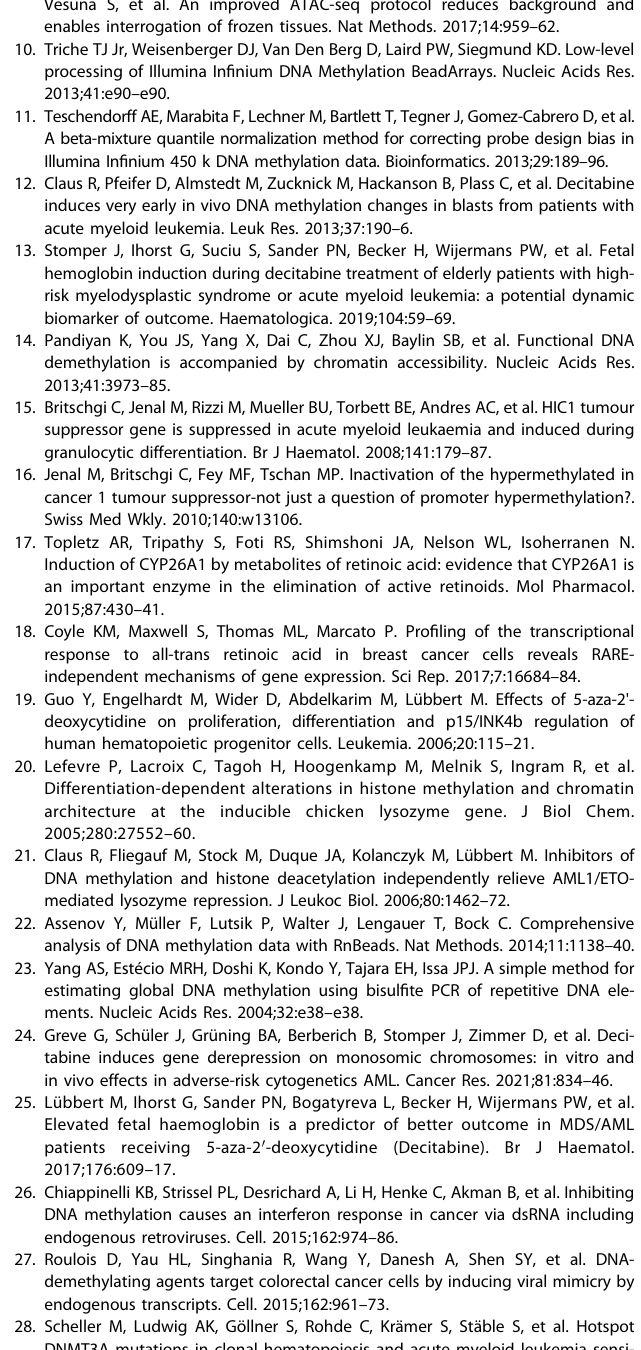
Fig. 8 Decitabine and ATRA cooperate in derepressing transposable elements in AML cells, activating dsRNA sensing. A Global expression changes of TEs in U937 and MOLM-13 were measured by RNA-seq (FDR < 0.05). Cells were treated with DAC, ATRA or both in combination and harvested 72 h after fi rst dose of Decitabine. Bar and Venn diagrams show the numbers of altered TEs for each treatment (DAC, ATRA, DAC + ATRA) in comparison to untreated; upregulated transcripts shown in red, downregulated in blue. B Comparison of regulated TEs in U937 and MOLM-13 treated with DAC + ATRA vs. untreated determined by RNA-seq. 102 out of 207 TE (49.3%) transcripts show concordance regarding induction vs. repression, as depicted in the lower graph. C Waterfall plots of the 10 most up- or downregulated TEs in U937 or MOLM-13 treated with DAC + ATRA. D Immunoblot results for RIG-I, MDA5 and MAVS in whole-cell lysates of U937 and MOLM-13 treated as indicated above. Beta-actin was used as loading control; the space between protein bands was cropped to conserve space. Results for the poly(I:C) sample in MOLM-13, repeated due to technical issues, were